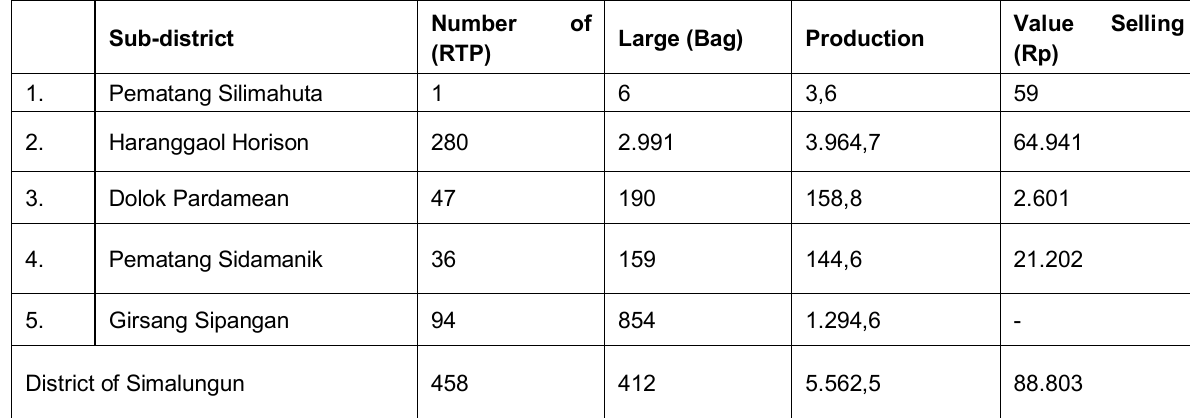
Table 1: Number of Fisheries Households (RTP), Area, Production and Value Selling of Farmers of Floating and Cage